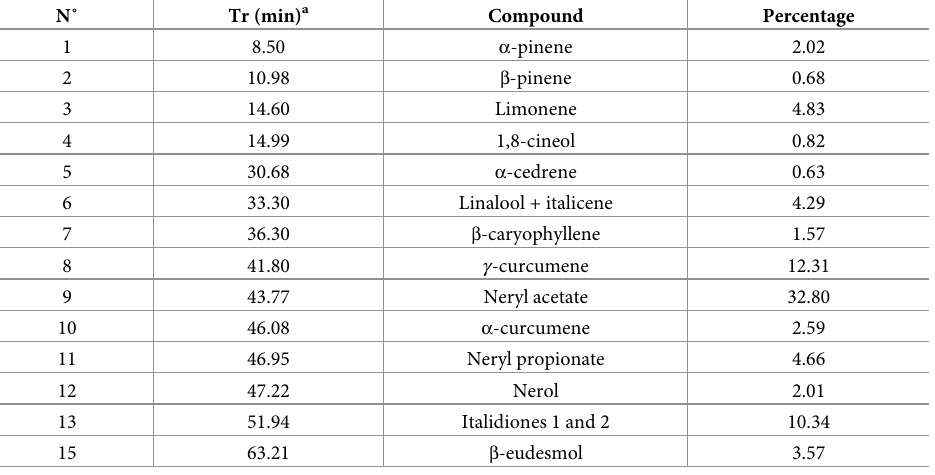
Table 1. Chemical composition of HIEO from